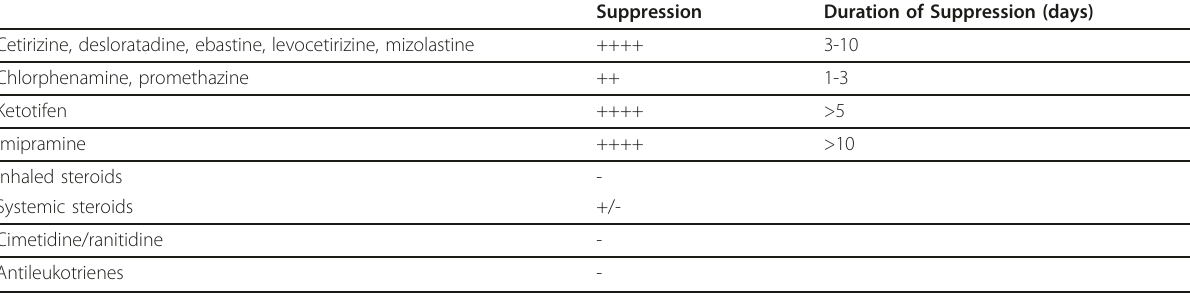
Table 3 Drugs affecting the results of skin